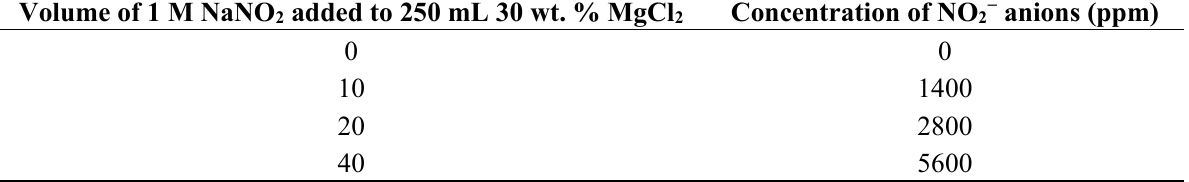
Table 1. Solutions used for electrochemical experiments to characterize the effects of nitrite